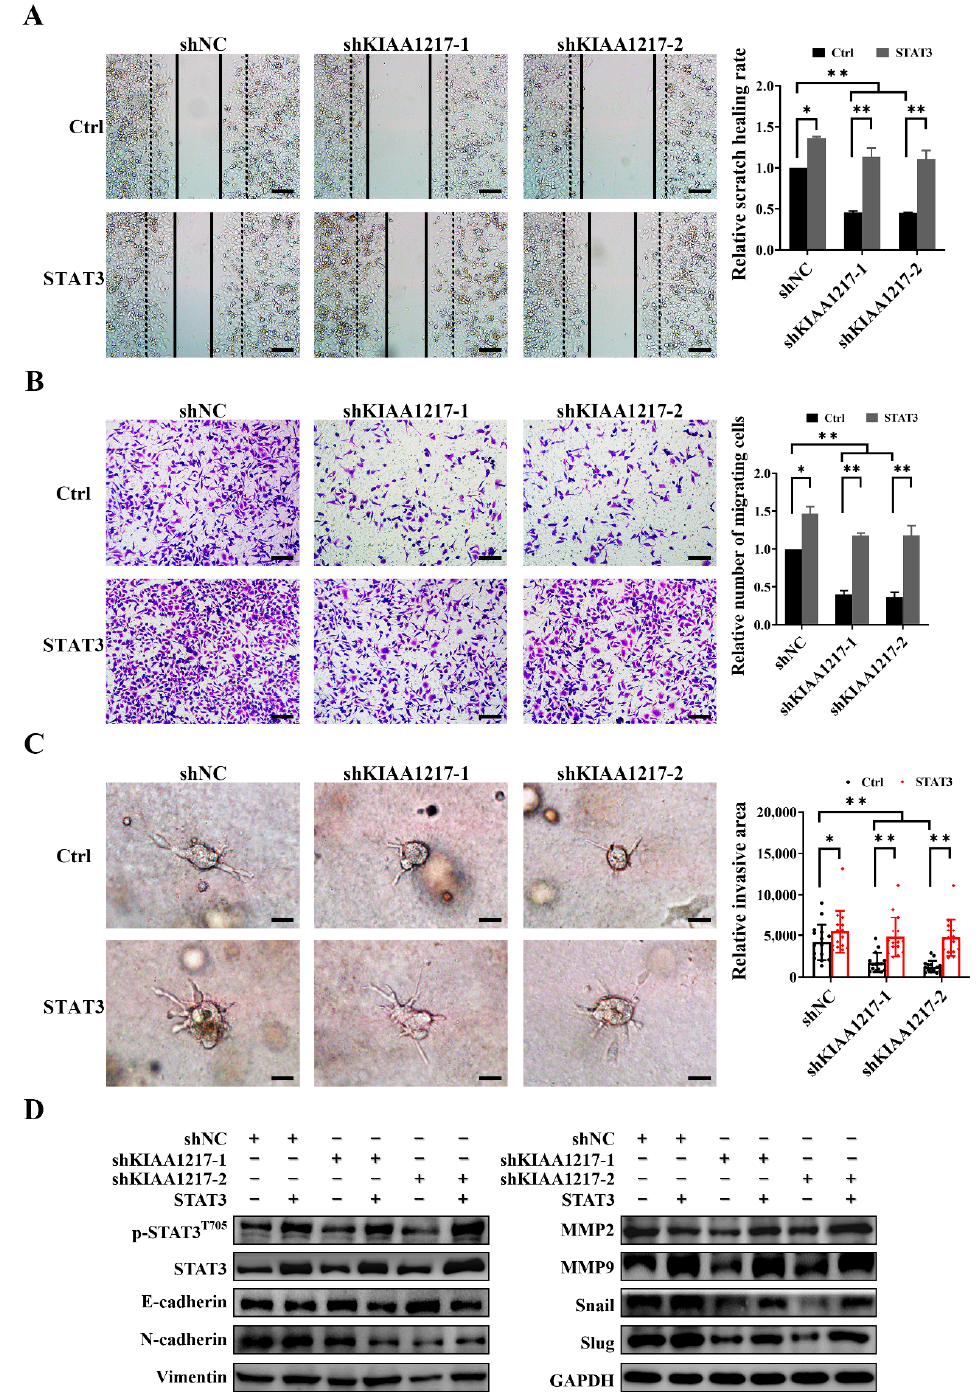
Figure 6. Overexpression of constitutively active STAT3 restored the impaired migration, invasion, and EMT of HepG2 cells with KIAA1217 knockdown. ( A ) The wound-healing assay was conducted at 48 h after scratching (magnification × 100; scale bars: 100 µ m). ( B ) Transwell migration assay (magnification × 100; scale bars: 100 µ m). ( C ) Cancer cell spheroid invasion assay in a 3D setting (magnification × 200; scale bars: 5 µ m). Ctrl denotes control cells transfected with empty vectors. ( D ) Western blot analysis of the expression of EMT markers. GAPDH was used as a loading control. * p < 0.05; ** p < 0.01. Error bars: